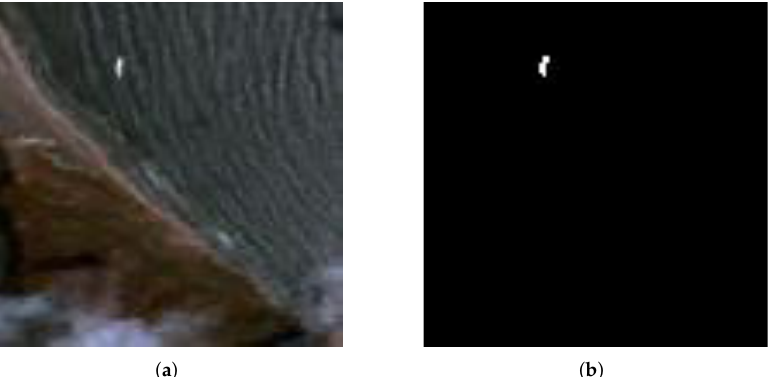
Figure 4. ABU-urban dataset and anomaly background response diagram. ( a ) Pseudo-color image. ( b ) Ground-truth map.